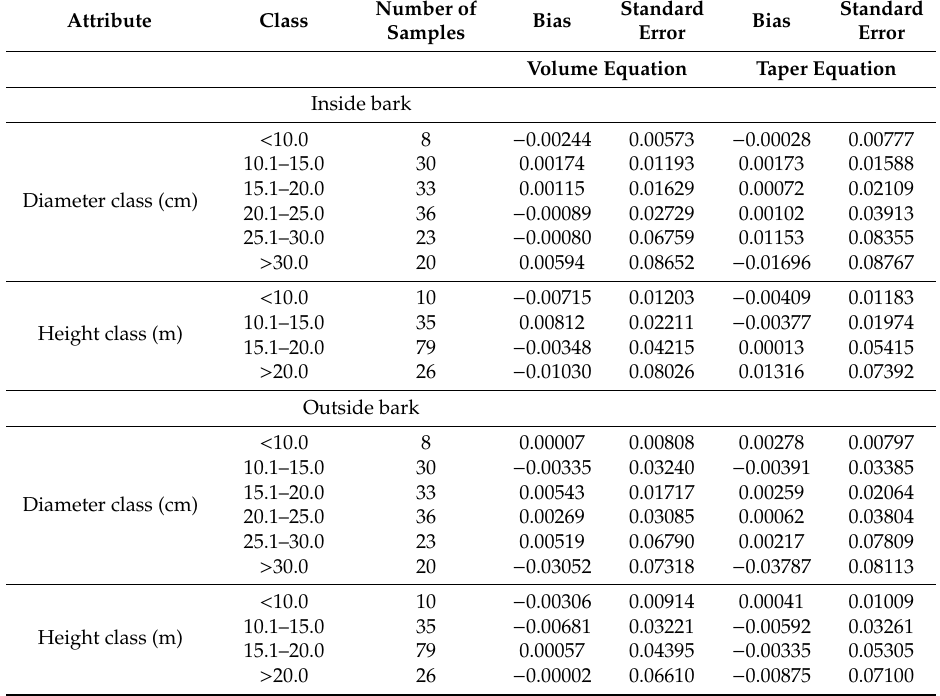
Table 4. Bias (observed–predicted) and its standard error of the residuals from volume equation (Equation (5)) and taper equation with stand density [6] for red pine plantations grown in Ontario, Canada.